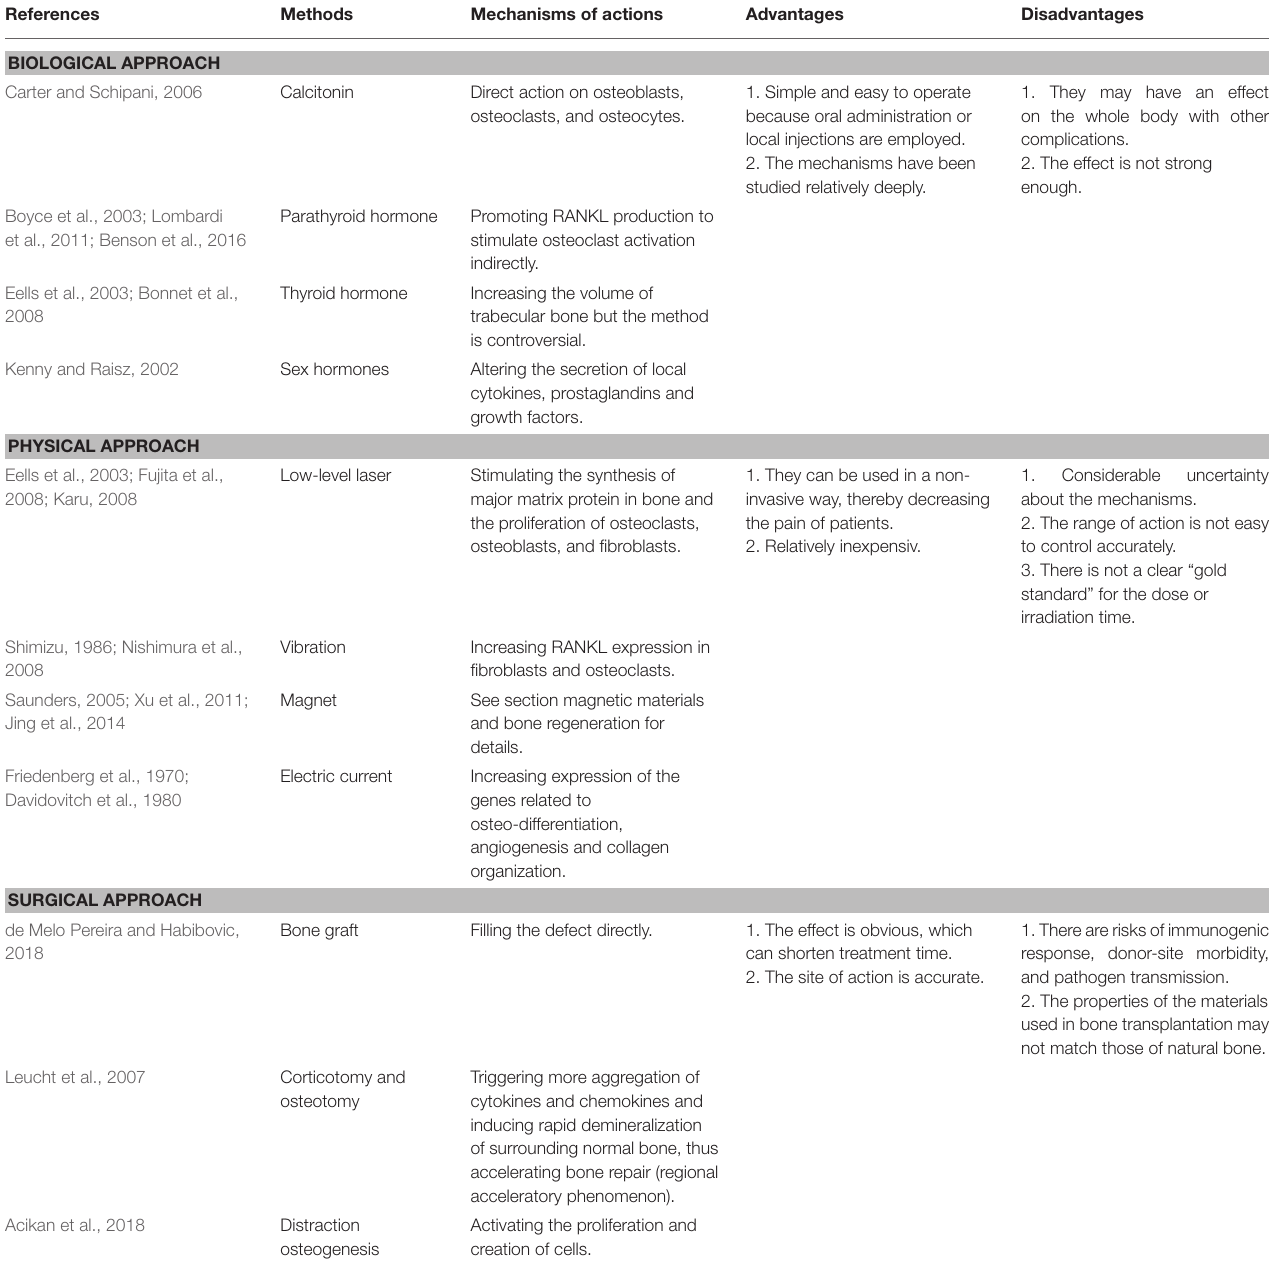
TABLE 1 | Common strategies employed to augment bone